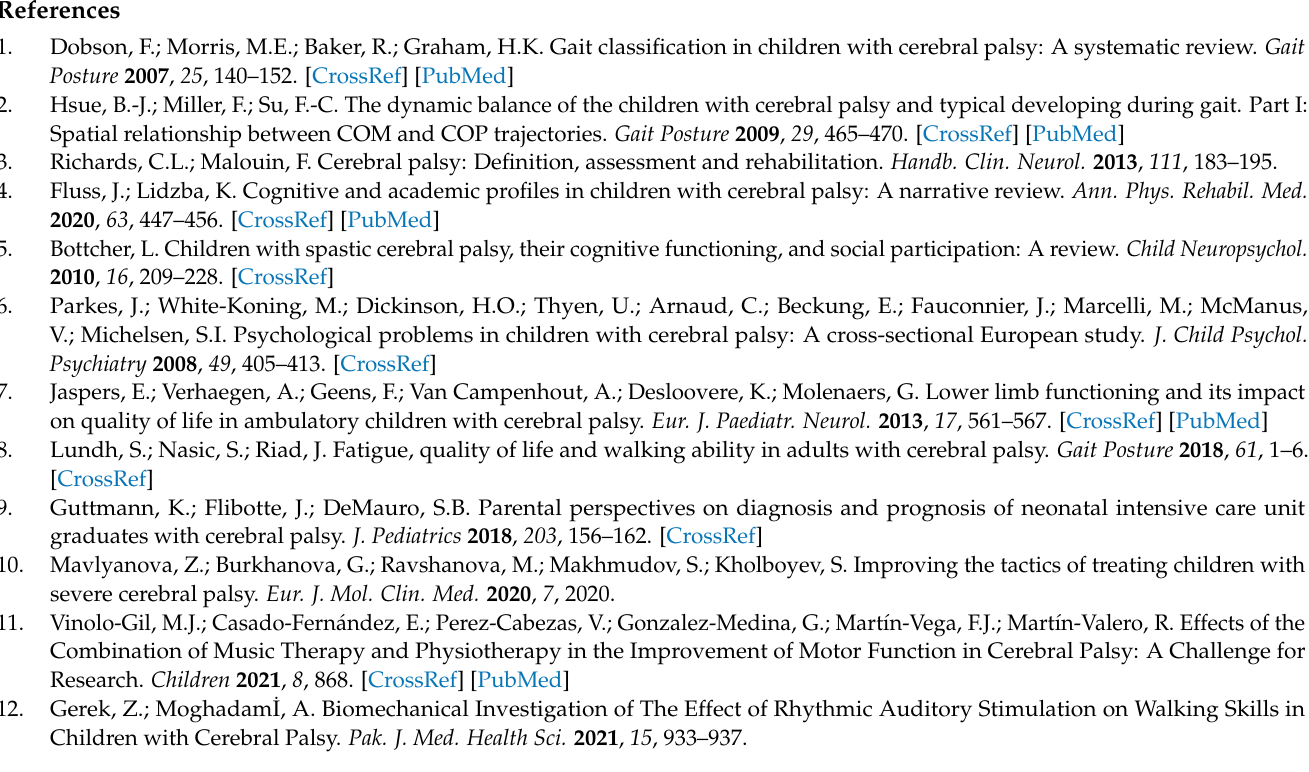
length in people with cerebral palsy, Figure S11: Forest plot illustrating the effect of AStim-based training on stride length in people with cerebral palsy (Controlled clinical trials), Figure S12: Forest plot illustrating the effect of AStim on cadence in people with cerebral palsy (Randomized controlled trials), Figure S13: Forest plot illustrating the effect of AStim on cadence in people with cerebral palsy (Controlled clinical trials), Figure S14: Forest plot illustrating the effect of AStim-based training on cadence in people with cerebral palsy, Figure S15: Forest plot illustrating the effect of AStim-based training on cadence in people with cerebral palsy (Controlled clinical trials), Figure S16: Forest plot illustrating the effect of AStim on gait deviation index in people with cerebral palsy, Figure S17: Forest plot illustrating the effect of AStim on gait deviation index in people with cerebral palsy (Controlled clinical trials), Figure S18: Forest plot illustrating the effect of AStim on gross motor function for standing (D-sub score) in people with cerebral palsy, Figure S19: Forest plot illustrating the effect of AStim on gross motor function for standing (D-sub score) in people with cerebral palsy, Figure S20: Forest plot illustrating the effect of AStim on gross motor function for walking (E-sub score) in people with cerebral palsy, Figure S21: Forest plot illustrating the effect of AStim on gross motor function for walking (E-sub score) in people with cerebral palsy, Table S1: PRISMA-P